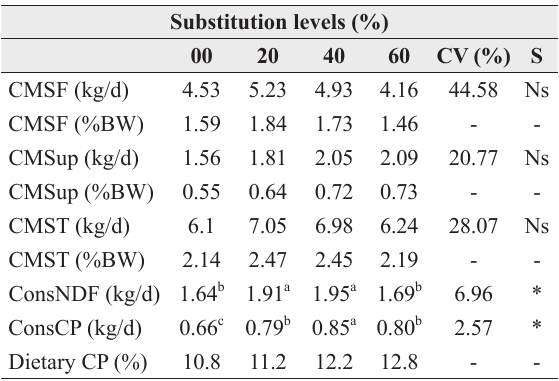
Dry matter intake of forage (CMSF), supplement intake (CMSS), total dry matter intake (CMST), neutral detergent fiber intake (NDF Cons) and crude protein intake (CP Cons ), expressed in kg / day and % CP